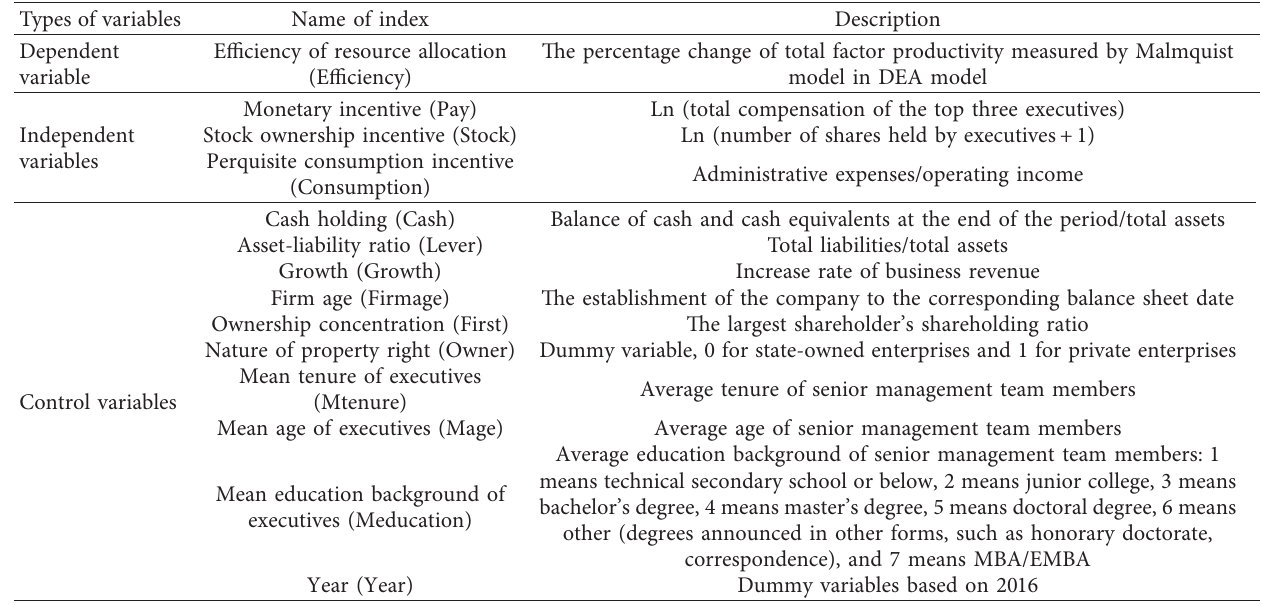
Table 2: Description of variables.